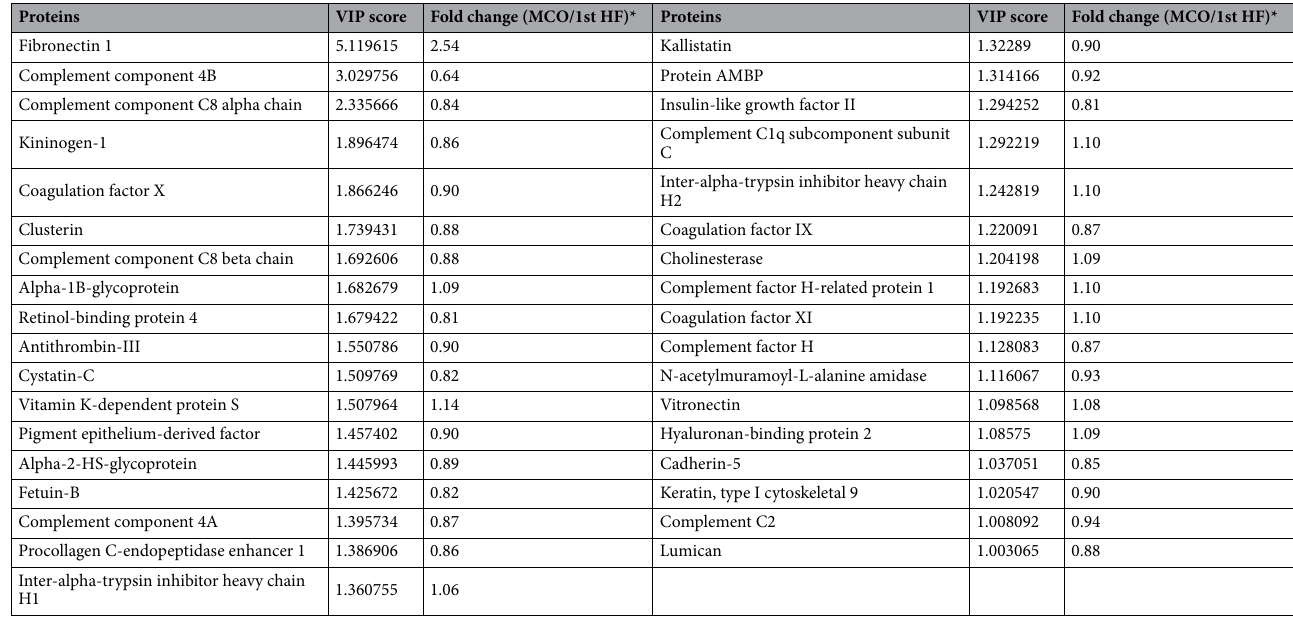
Table 3. VIP score of proteins differentially expressed between the 1st HF and MCO dialyzer groups. *Protein with a fold change of MCO/1st HF < 1.0 means decreased during the MCO period. In contrast, protein with